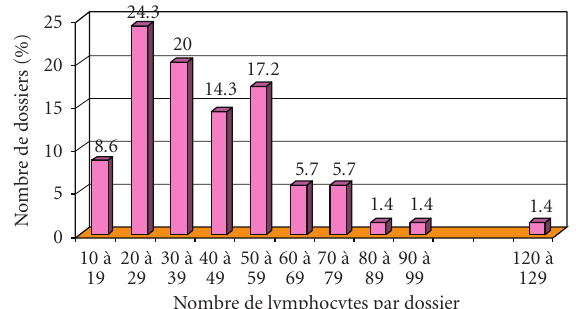
Figure 5: Distribution of the number of lymphocytes per file.